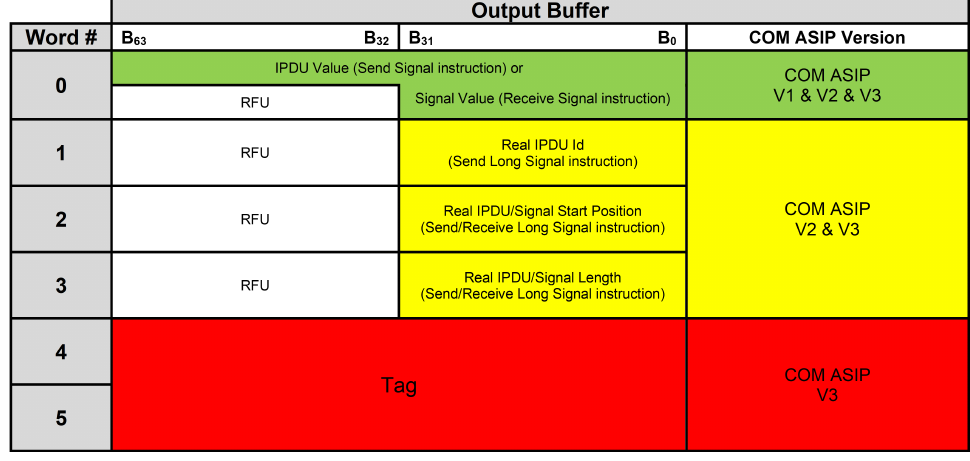
Figure 17. The modified output buffer component.